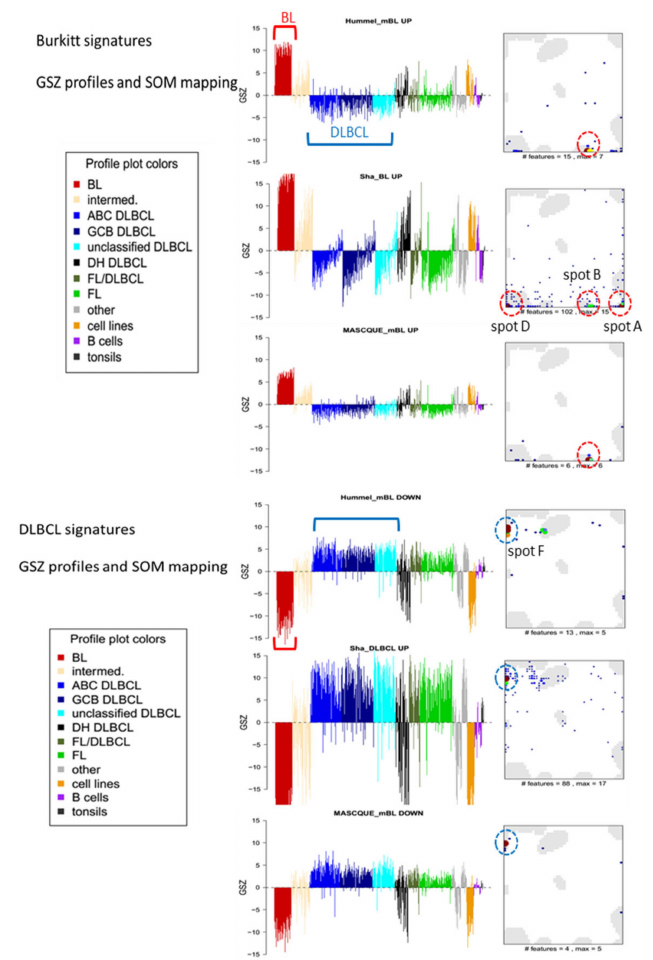
Figure A8. Characteristics of BL-vs-DLBCL signatures: GSZ-profiles of the BL_up signatures show high (GSZ >0) values for BL (red), lymphoma-cell lines (apricot) and, to a lesser degree, intermediate lymphoma (beige) and low values (GSZ <0) for DLBCL (ABC, GCB, and unclassified; blue and cyan, respectively), and FL (green). The patterns virtually reverse for DLBCL_up signatures. SOM mapping indicates accumulation of signature genes, first of all, in/near spot B but also in/near spots D and A (red circles). Especially, part of the Sha-BL_up signature genes are found in spot D which associates with increased cell division. Samples in each subtype were sorted with increasing expression of the cell-cycle activity from the left to the right. The increasing slope of the Sha-BL_up GSZ-values along most of the subtypes reflects the relation of this signature to